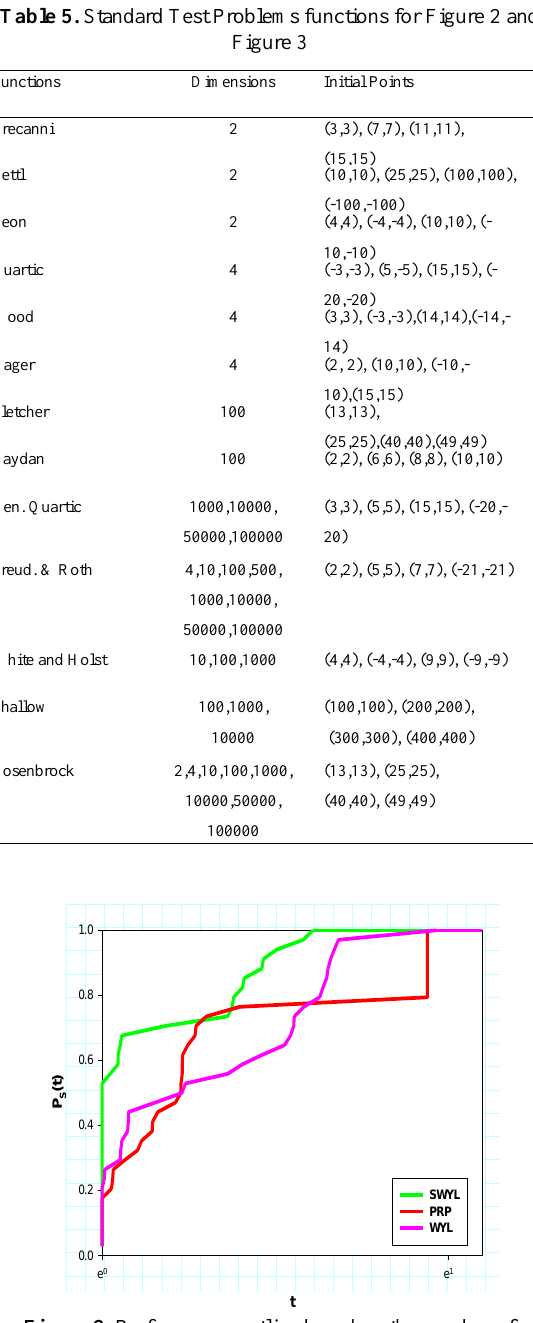
Figure 2. Performance outline based on the number of iterations